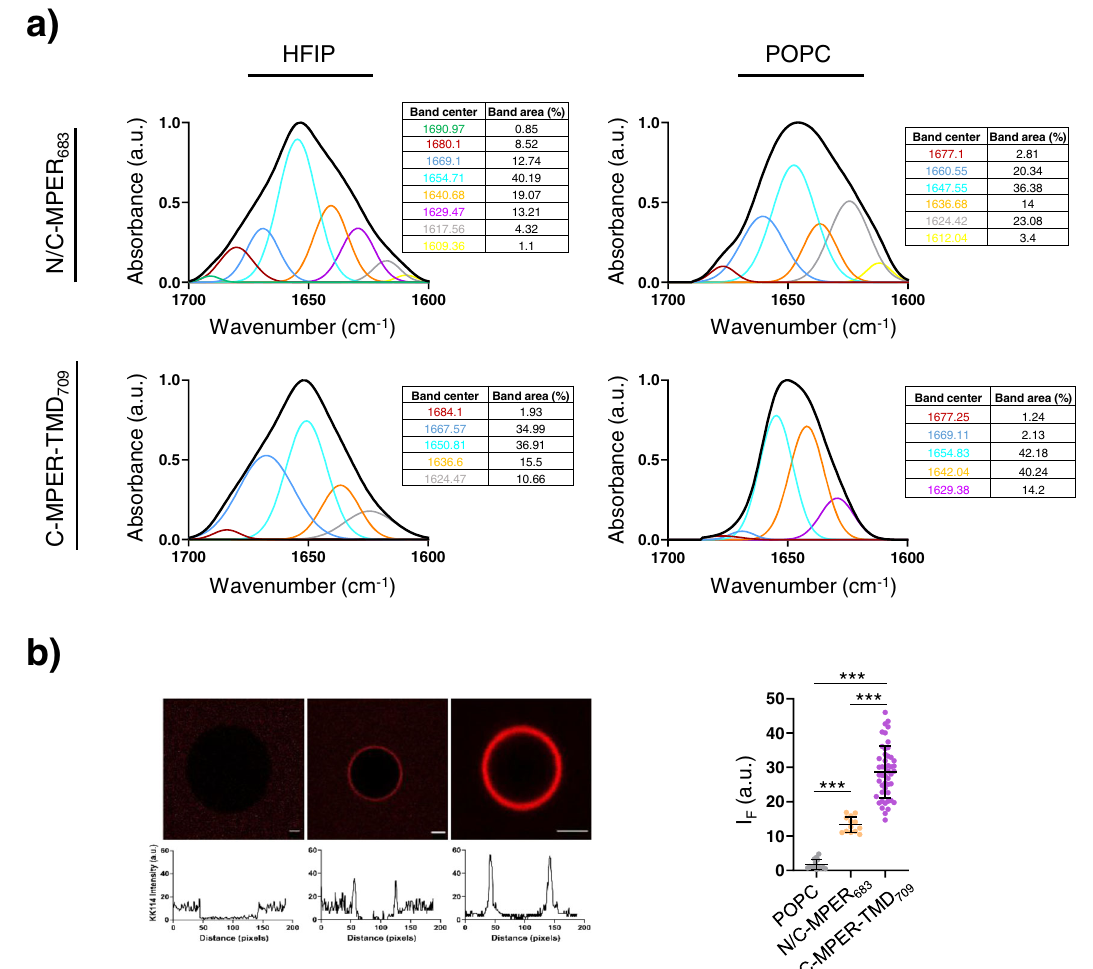
Fig. 3 10E8 recognition of C-MPER helices reconstituted in POPC vesicles. a Reconstitution of the peptides in lipid bilayers. IR absorption bands in the amide I region obtained for peptides in 50% HFIP (v:v) (left panels) or after reconstitution in POPC membranes. Percentages contributed by each band component are displayed in the side Tables. The peptide-to-lipid ratio was 1:50 (mol:mol). b Binding of Fab 10E8 to single POPC vesicles containing the peptides reconstituted. Left: Confocal microscopy images of single POPC vesicles with or without the peptides and incubated with KK114-Fab 10E8 (red label). Traces below follow the changes in KK114 fl uorescence intensity at the equatorial plane. Right: KK114-Fab 10E8 intensities measured in the different GUV samples. In samples containing peptide the peptide-to-lipid ratio was 1:250 (mol:mol). Scale bars are 2 µ m. Number of vesicles n ≥ 13. Center line, mean; whiskers SD (Mann – Whitney Test: *** p < 0.001; ** p < 0.01, * p < 0.05, n.s. ≥